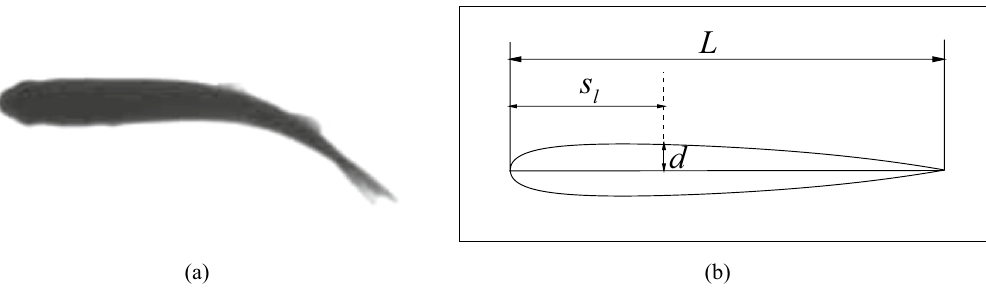
Figure 1. A schematic of the fish model: ( a ) ventral view of a trout 49 ; and ( b ) the constructed shape of a 2D